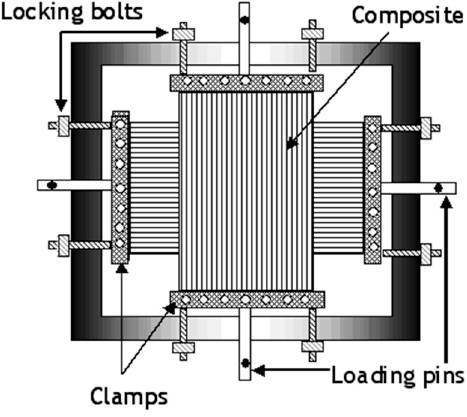
Figure 7. Schematic illustration of the biaxial loading frame-based prepreg pre-stressing method [43].